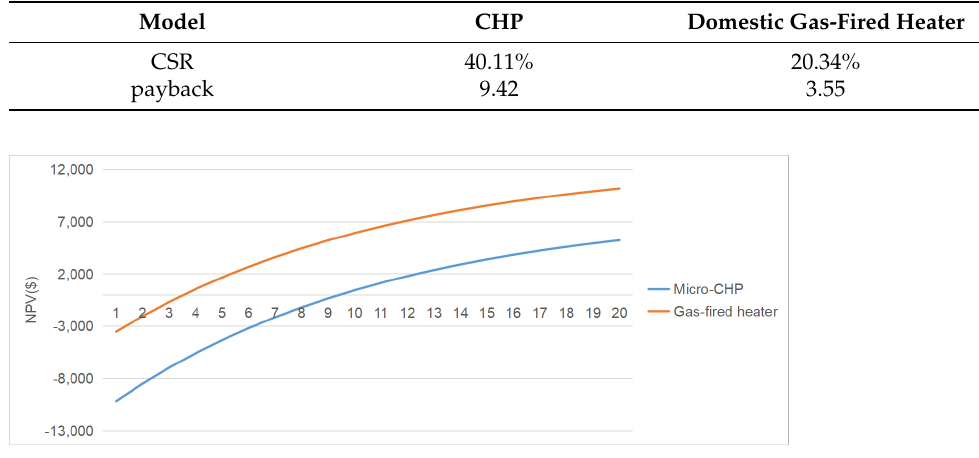
Figure 6. Comparison of NPV for CHP and domestic gas-fired heater.